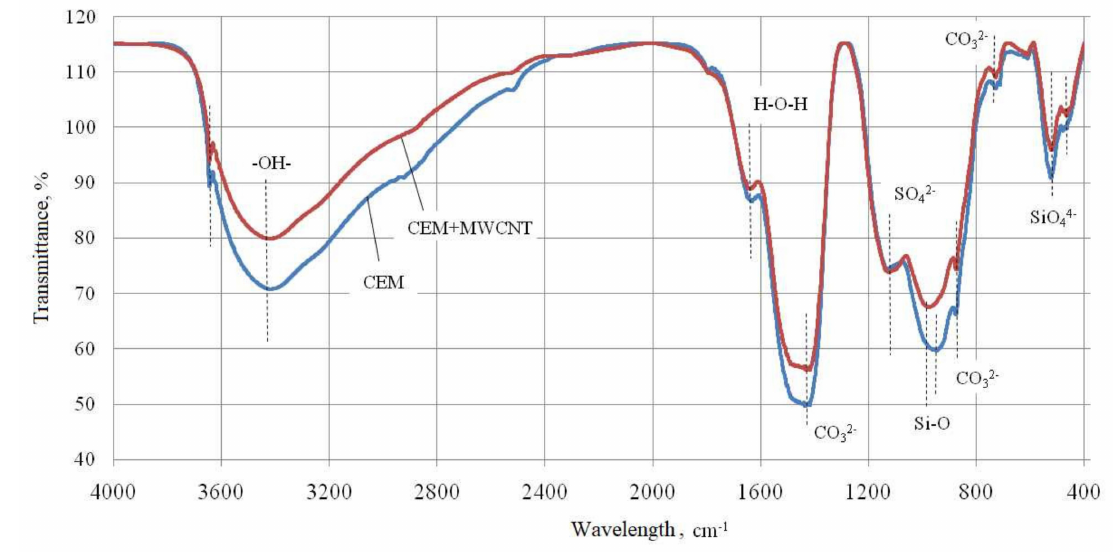
Figure 7. Fourier-transform infrared spectroscopy for the nanomodified hardened cement paste cured for 28 days under normal